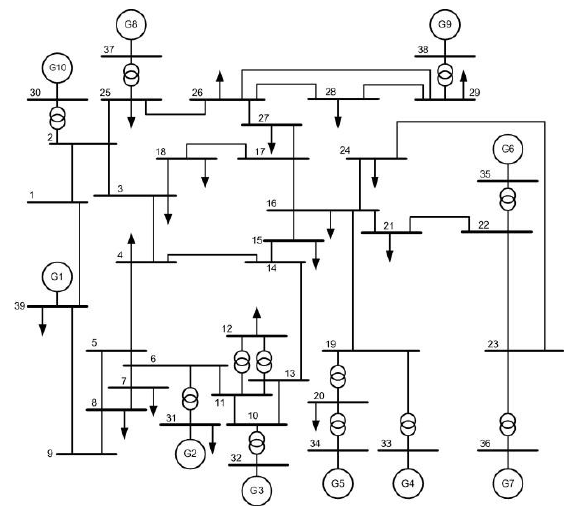
Fig. 5. IEEE 39 Bus System.